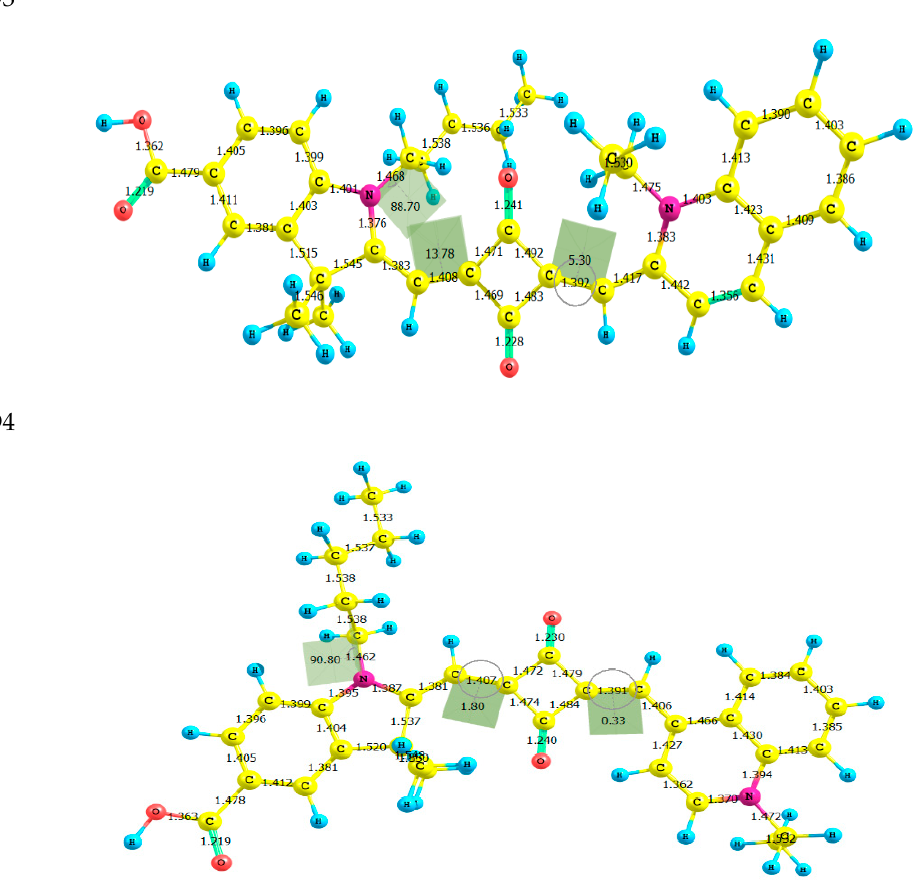
Figure 1. Optimized geometries and selected bond lengths (Å) and dihedral angles (°) of dyes SQD1-SQD4 using B3LYP/6-311++G** level of theory. Green color and rings indicate dihedral angles.